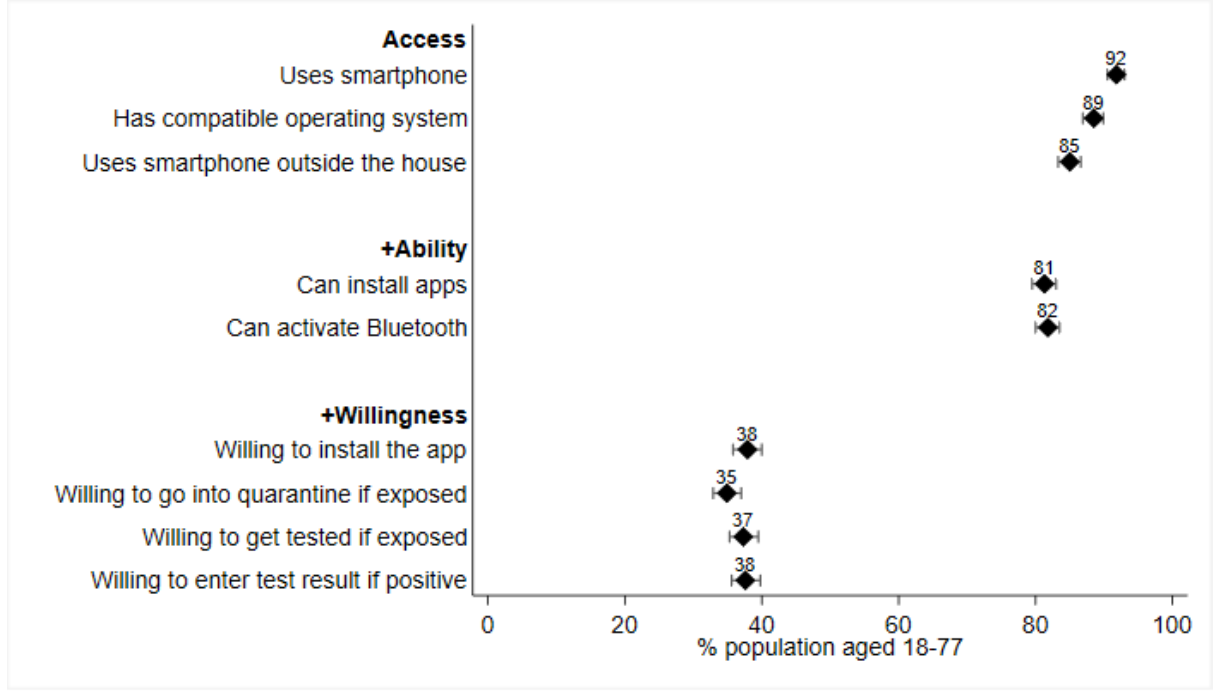
Figure 1. Predicted adoption rates by access, ability, and willingness (N=3276). Error bars represent 95% CI.